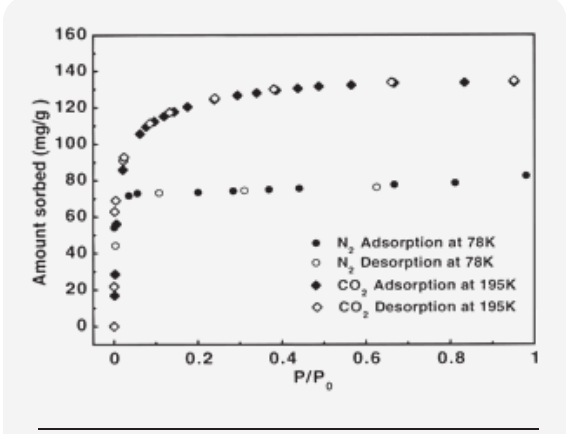
Fig. 1b. N 2 adsorption isotherm of MOF-2 proving its permanent porosity. The CO 2 isotherm is also shown. These isotherms constitute the fi rst proof of porosity in MOFs. From this data porosity values can be obtained.